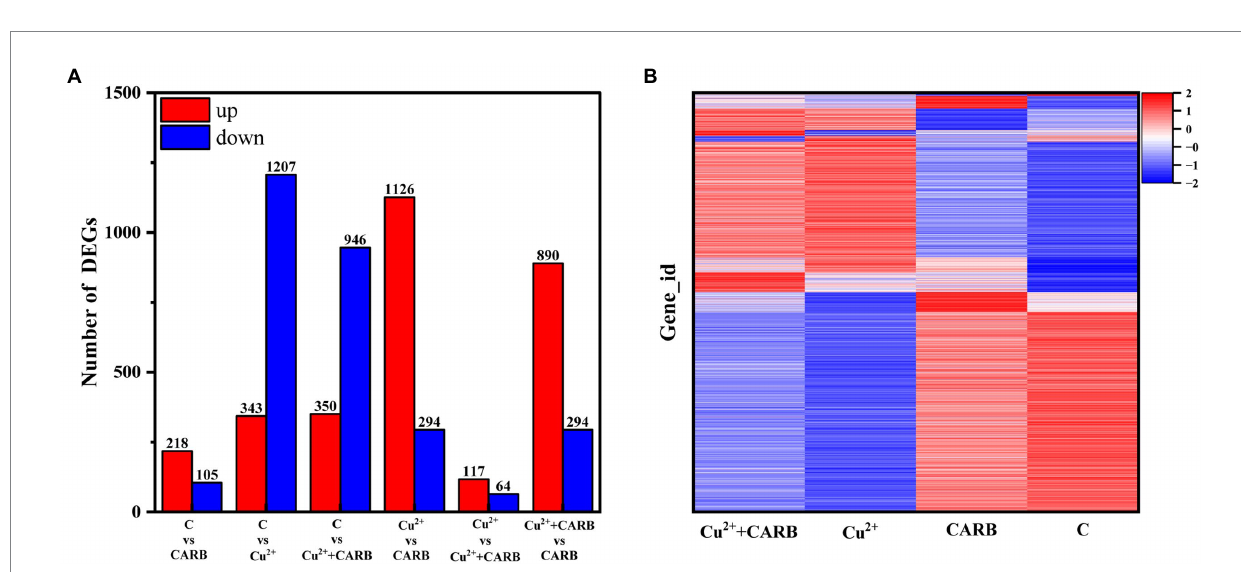
FIGURE 5 Differential expression analysis of experimental and control group. (A) Overall situation of differential genes in the three comparison groups. (B) Cluster diagrams. Different groups are represented horizontally. and different genes are represented